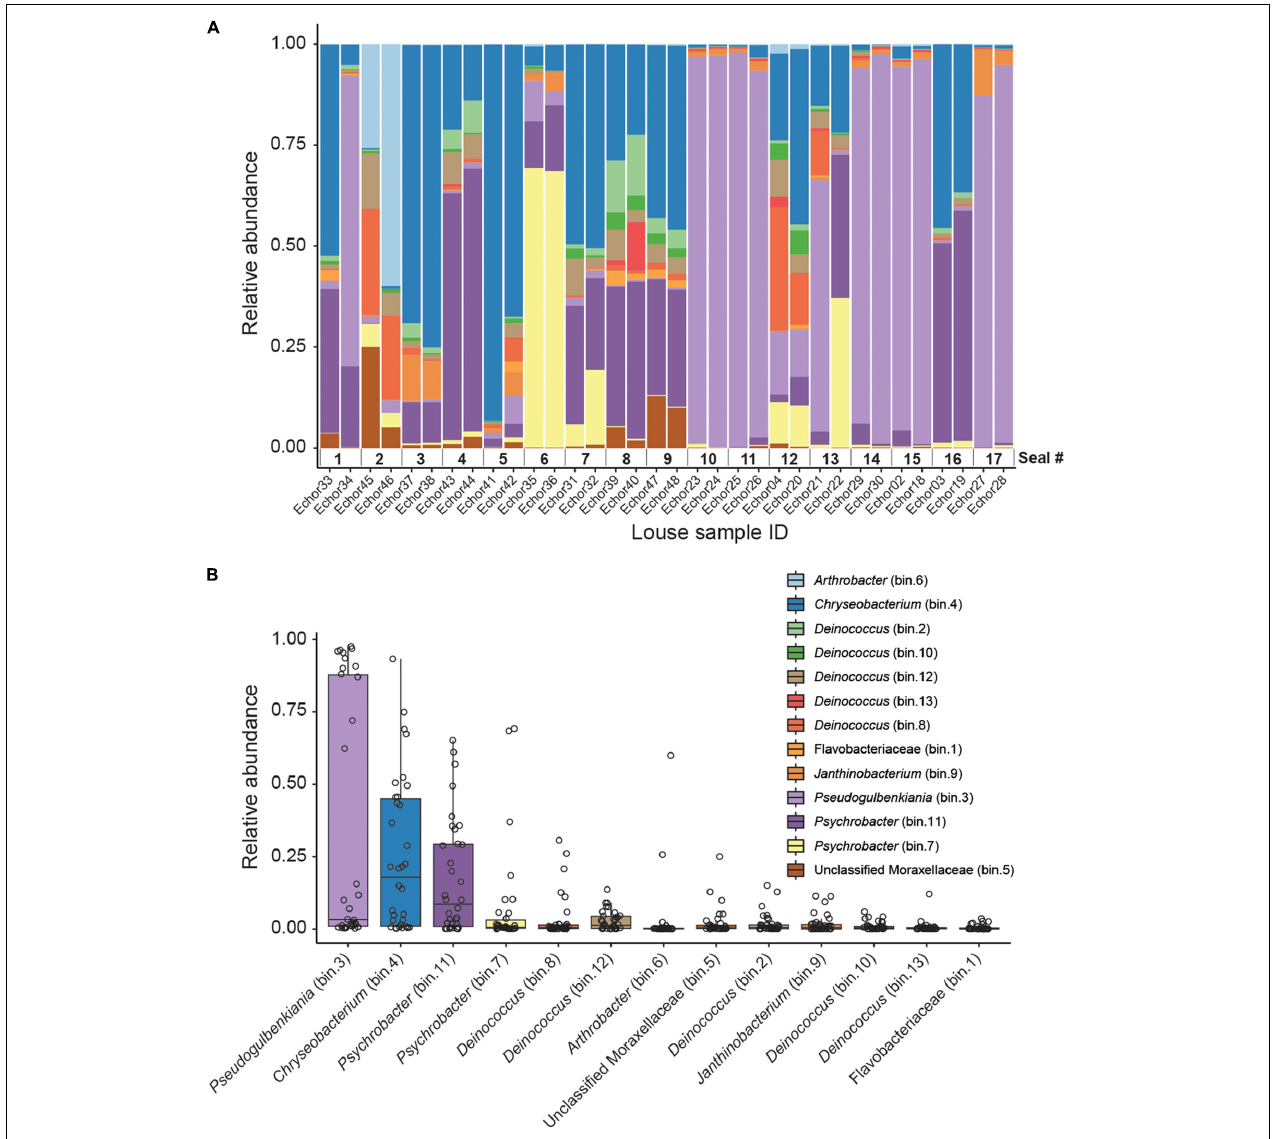
FIGURE 1 | Genome-resolved metagenomic data. (A) Stacked bar plot showing the relative abundances of MAGs in each louse sample. Note that samples are ordered according to host (i.e., samples from the same host are next to each other). (B) Boxplot summarizing the relative abundance of each MAG across the louse samples. Individual points (horizontally jittered) depict the relative abundance of each MAG in each